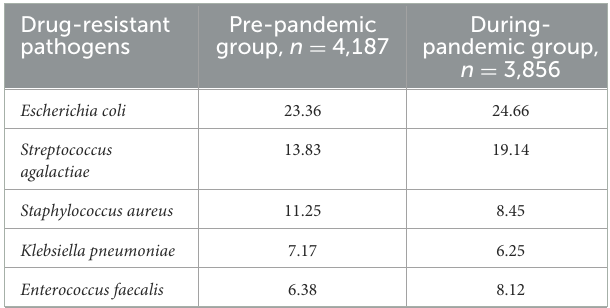
TABLE 1 Observed infection rates (%) of drug-resistant pathogens. Drug-resistant